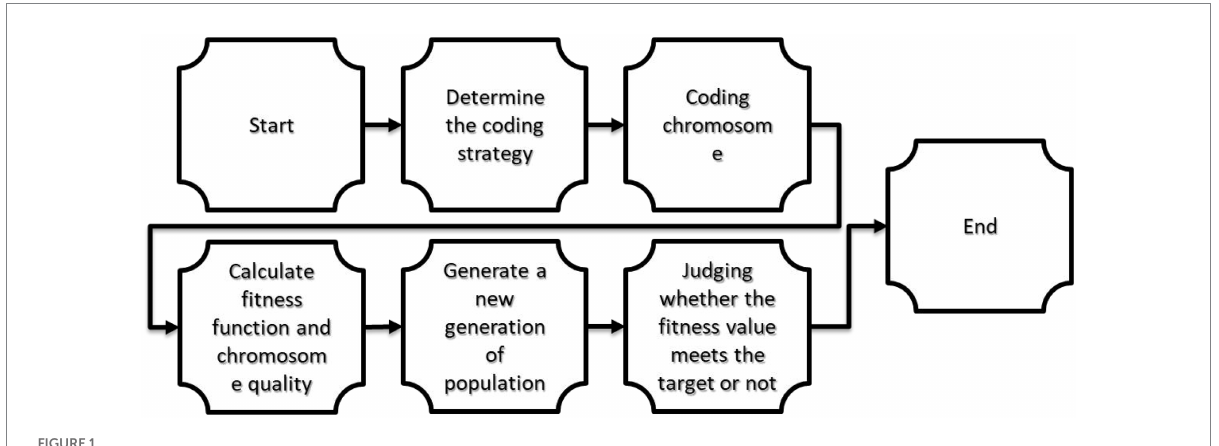
FIGURE 1 Schematic diagram of genetic algorithm